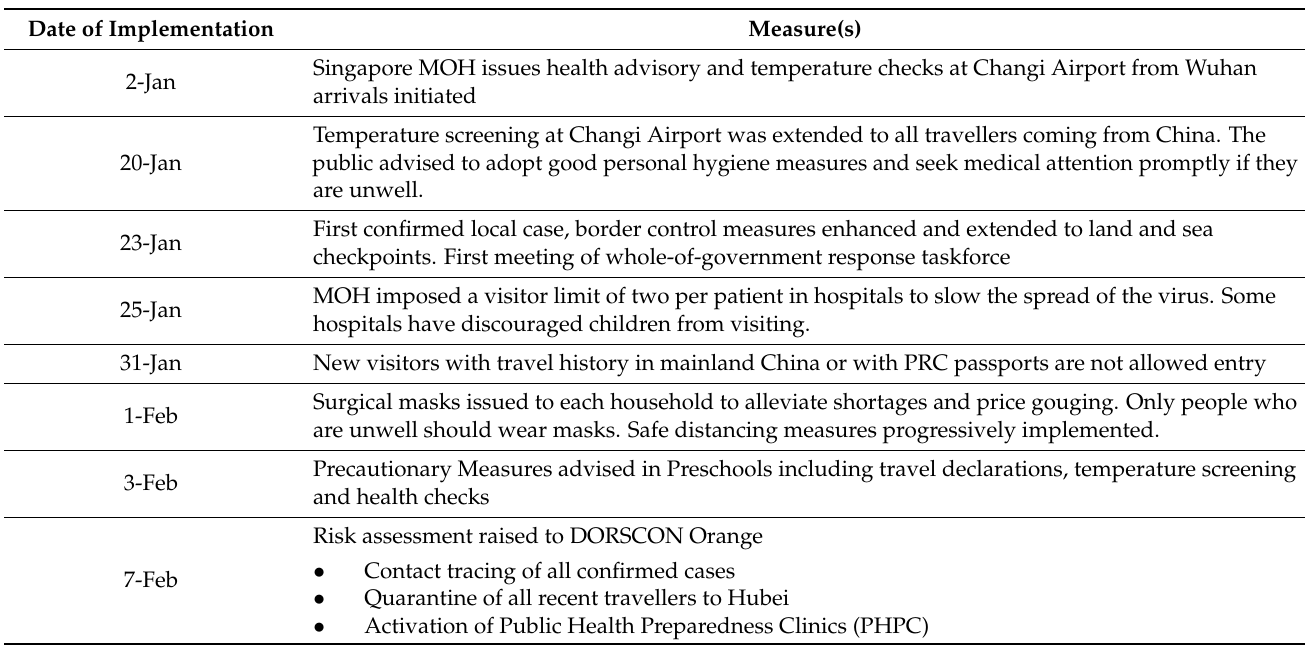
Table 1. Timeline of non-pharmaceutical measures implemented by Singapore in response to the COVID-19 pandemic [45]. Date of